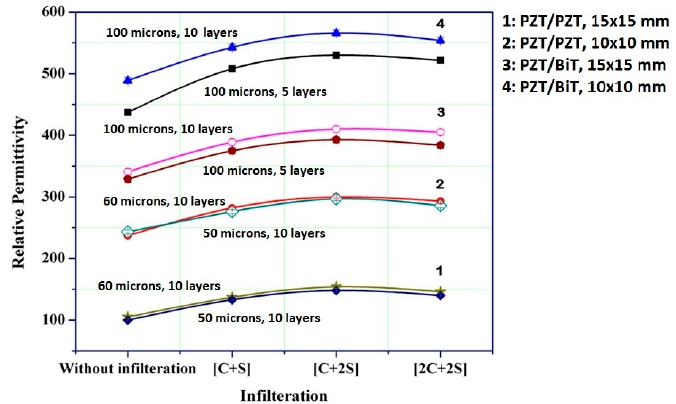
10 of 16 Figure 9. The C-T variations for the PZT/PZT films at 25–330 °C, ( a ) L 3 -A and ( b ) L 3 -B. 4.6. Dielectric Permittivity ( ε r ) According to the acquired results shown in Figure 10, there is a rise in dielectric permittivity ( ε r ) as the number of layers, and the infiltration steps increase; nevertheless, the dielectric loss ( tan δ ) remains almost constant. It might happen due to a mitigation in material porosity and improvement in the bonding of piezoelectric powder particles with the sol-gel matrix. Concerning the dielectric permittivity of the samples, porosity acts like series or parallel capacitors in conjunction with the adjacent dense piezoelectric columns. As the volumetric ratio of porous cavities (filled with air) to the piezoelectric film increases, the tendency of the air dielectric permittivity to be placed in serial, versus parallel, with that of the composite film increases. In other words, the volume of porous cavities adversely affects the relative dielectric constant.